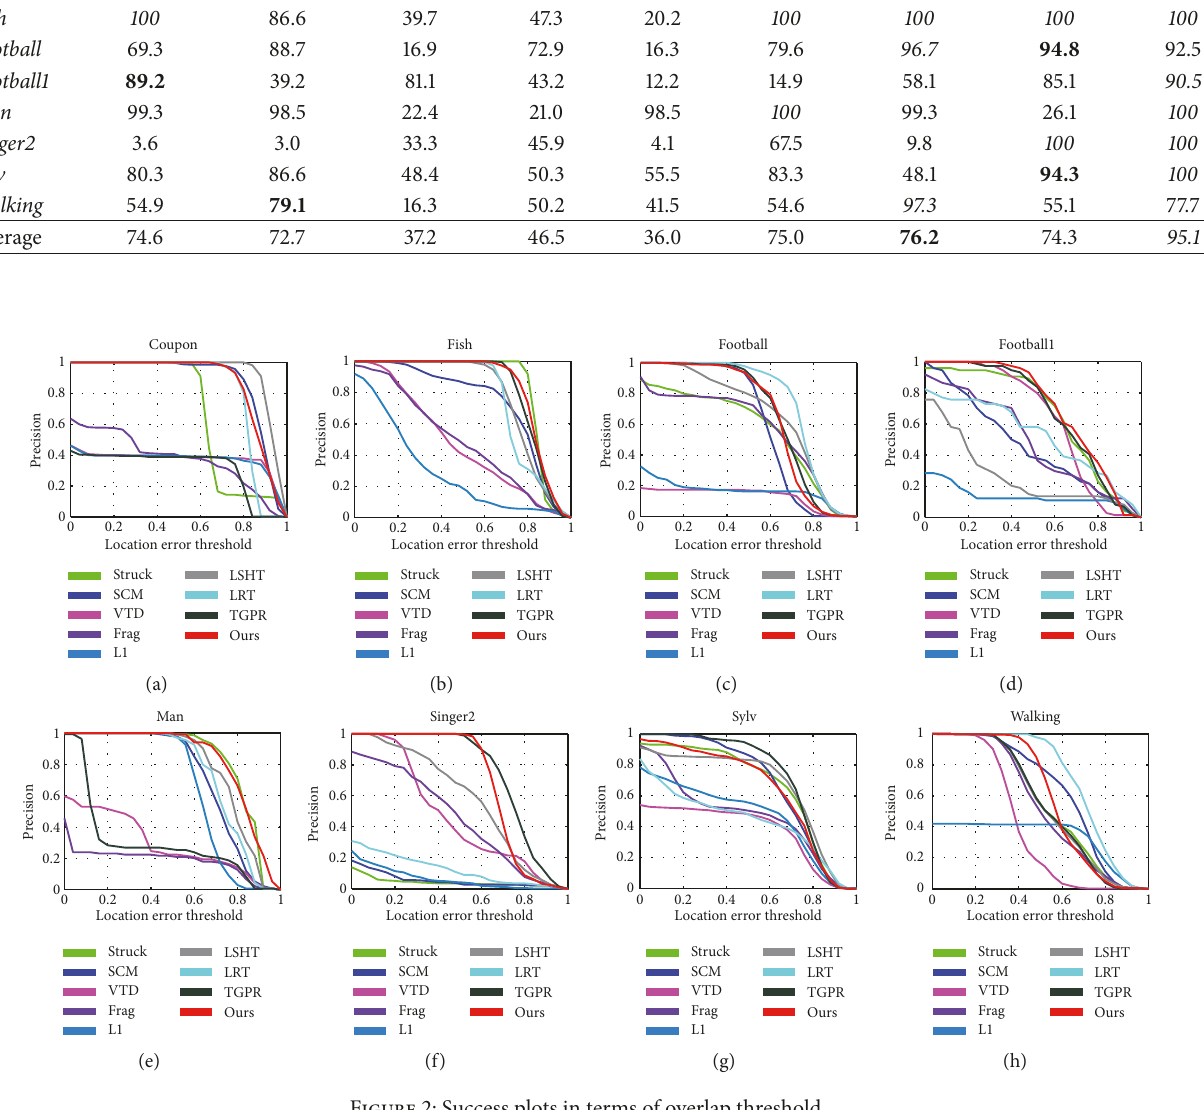
Figure 2: Success plots in terms of overlap